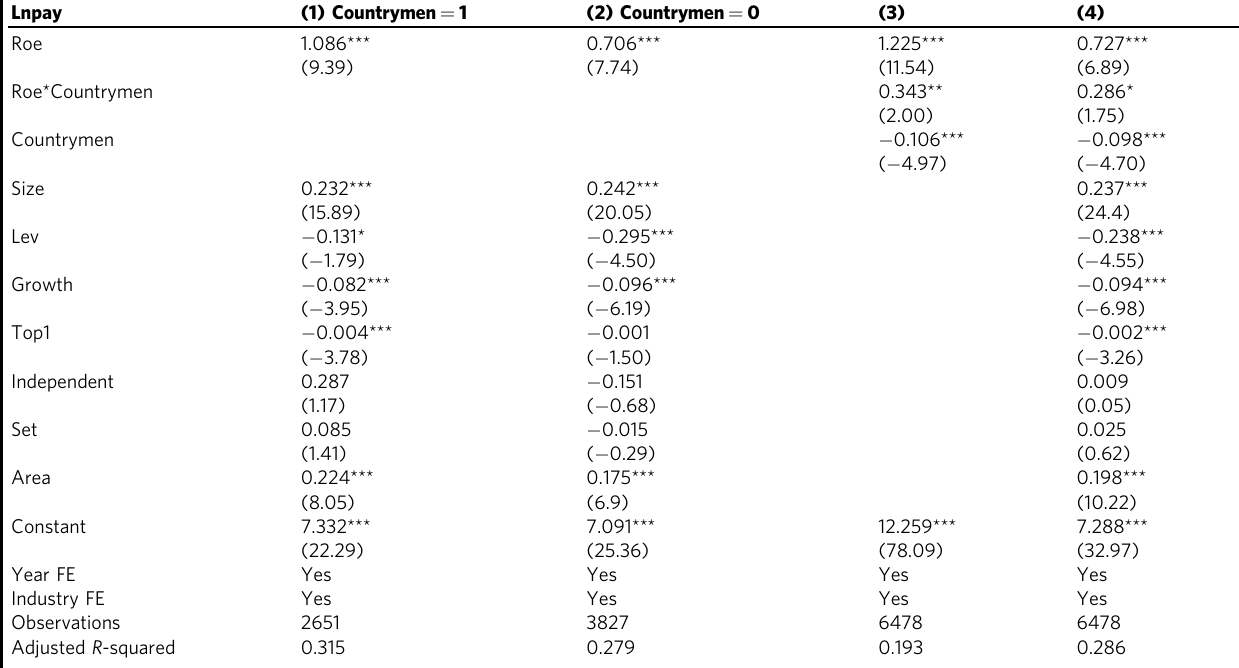
Table 6 Effect of CEOs ’ hometown connections on compensation – performance sensitivity.